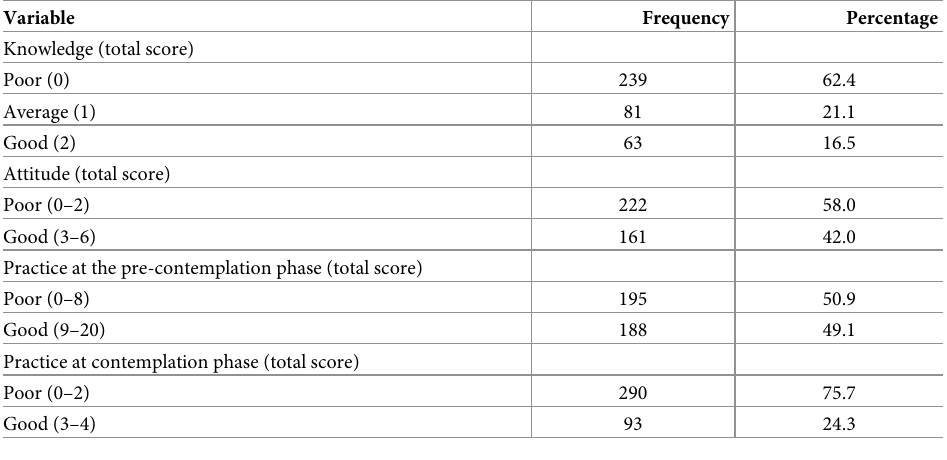
Table 2. The level of knowledge, attitude and practice of smoking cessation management among primary care doctors. Variable Frequency Percentage Knowledge (total